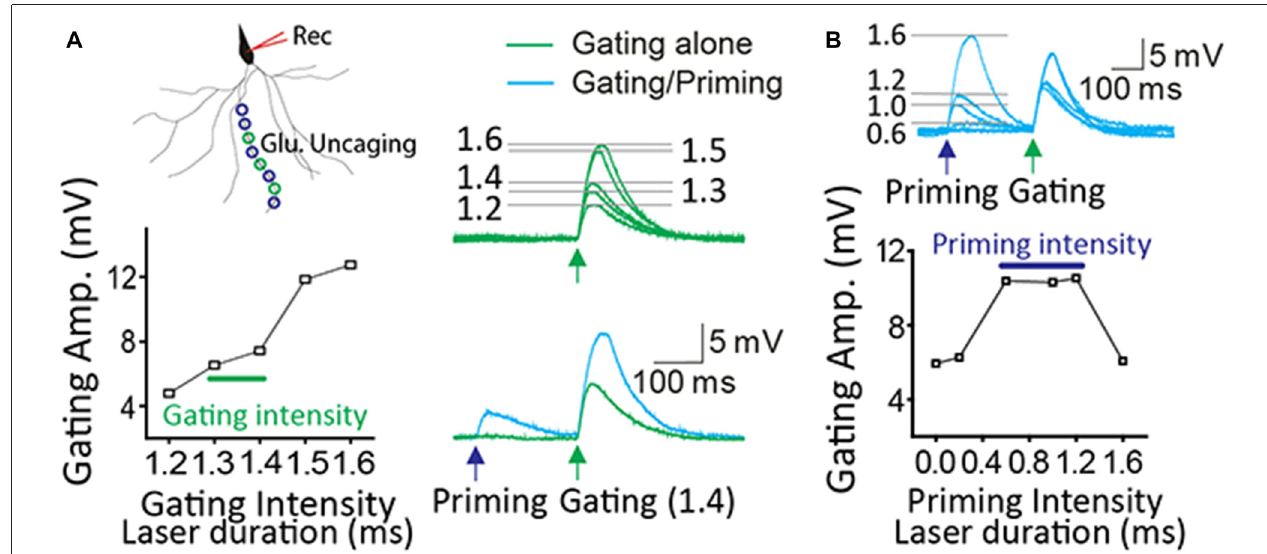
FIGURE 1 | Optimization of priming and gating intensity. (A) The priming stimulation produced the potentiated read-out response when gating stimulation was set up just prior to a dendritic spike. (B) There are a certain range of priming signals to generate a read-out response efficiently. In this case, priming intensity (0.6 ∼ 1.2 ms laser duration) produced the facilitation when gating intensity ranged from 1.3 to 1.4 ms.